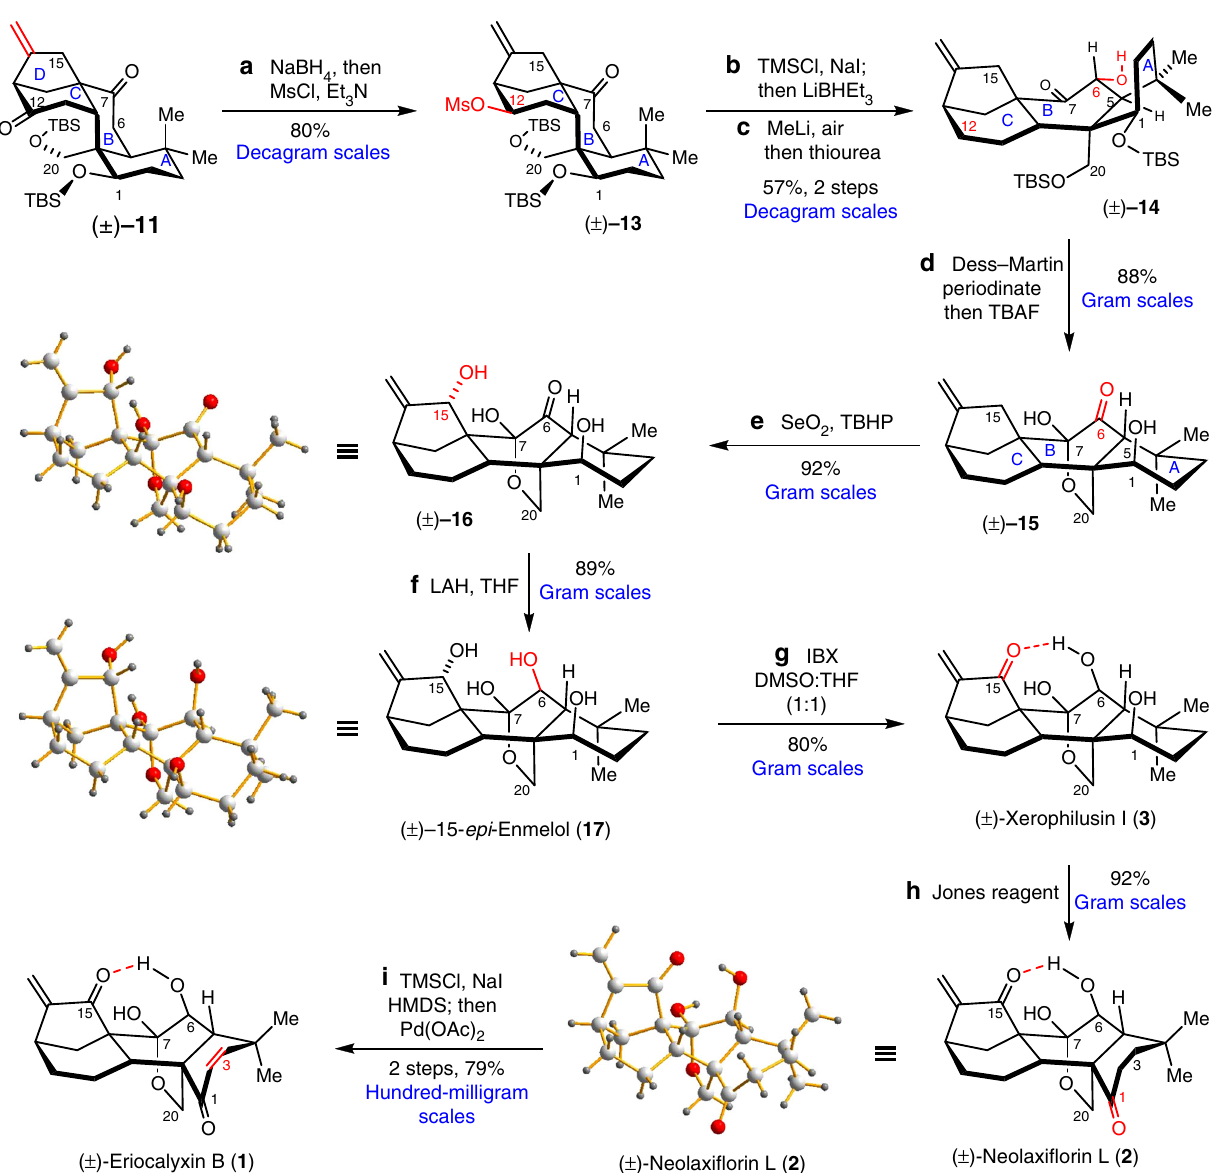
Fig. 4 Total Syntheses of Isodon diterpenoids. With (±) − 11 as the common intermediate, the total syntheses of (±)-eriocalyxin B ( 1 ), (±)-neolaxi fl orin L ( 2 ) and (±)-xerophilusin I ( 3 ) were achieved via a conformation and H-bond guided redox – relay strategy in 7 – 10 steps with 19 – 26% overall yields. The synthetic route can be operated in hundred-milligram-to-decagram scales